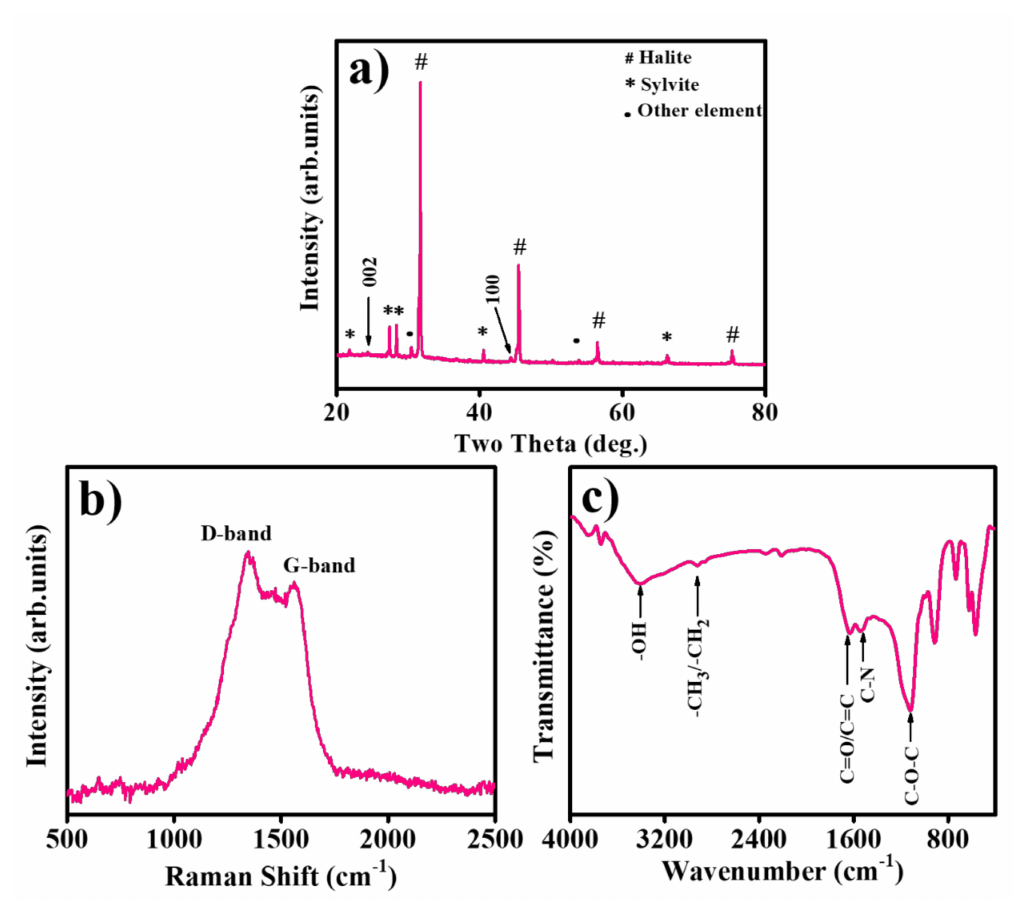
Figure 2. ( a ) XRD, ( b ) Raman analysis, and ( c ) FTIR patterns of